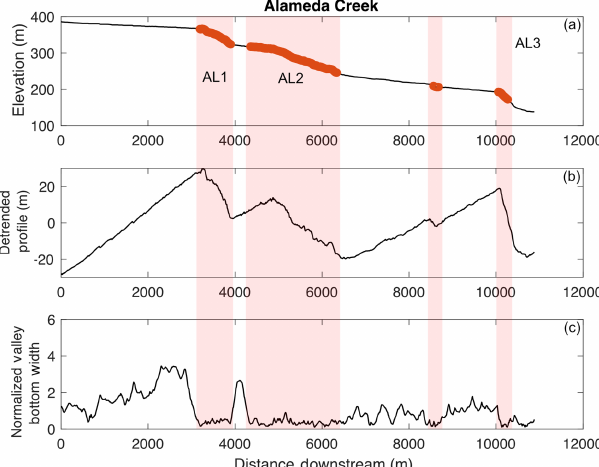
Figure 6. (a) Elevation long profile of Alameda Creek. Locations where the channel intersects mapped earthflows in Figs. 2 and 3 are shown in red and labeled. (b) Detrended elevation profile of Alameda Creek for the reach shown in panel (a) . (c) Valley bottom width for Alameda Creek normalized by the mean valley bottom width over the reach shown in panel (a) . In panels (a) – (c) , the red boxes highlight earthflow-impacted